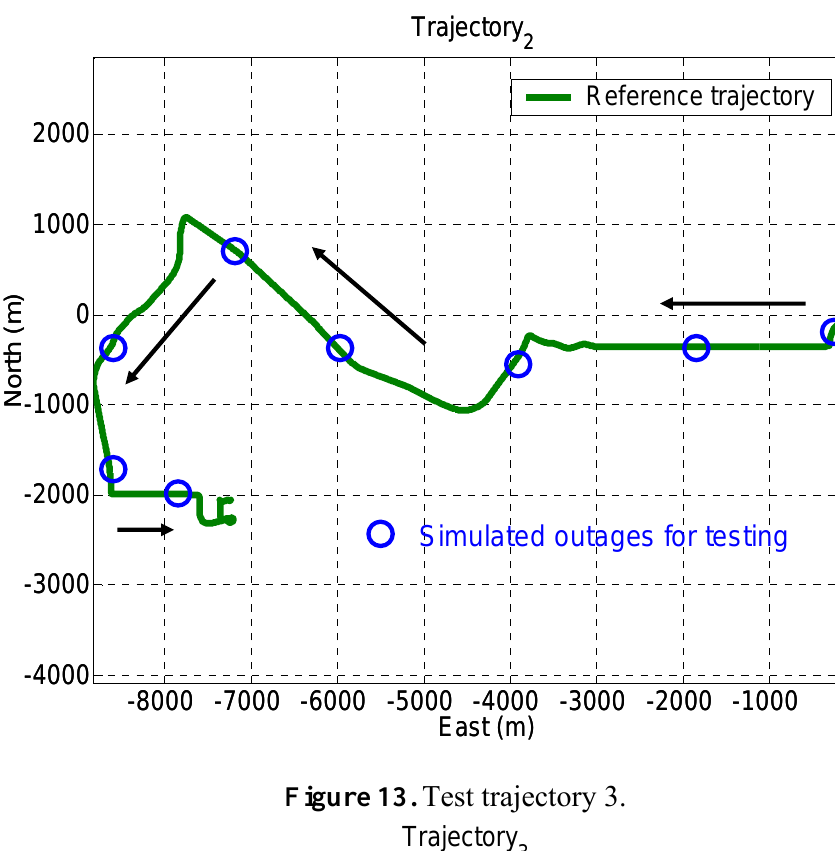
Figure 12. Test trajectory 2.